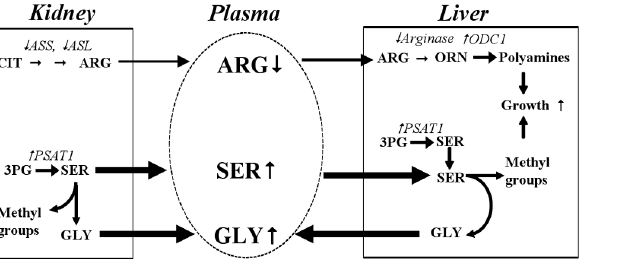
Fig. 7. Schematic overview of suggested PPAR a mediated changes in amino acid de novo synthesis. WY 14,643 reduced renal arginine (ARG) output, via down regulation of arginosuccinate synthetase (ASS) and argininosuccinate lyase (ASL), and increased tissue serine (SER) biosynthesis, via up regulation of phosphoserine aminotransferase 1 (PSAT1) with gene regulation previously shown in [2]. Available hepatic arginine is diverted to polyamine synthesis via altered gene expression including ornithine decarboxylase 1 (ODC1) up regulation [2]. Serine is used to provide methyl group transfer to support expected PPAR a - mediated liver growth and in the process generating glycine (GLY). CIT, citrulline; ORN, ornithine; 3PG, 3- phosphoglycerate.